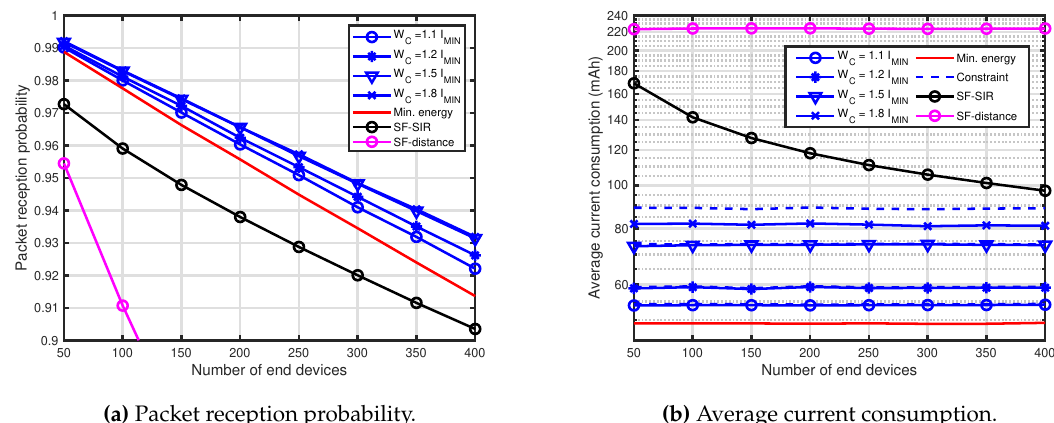
= 1.1 I mAh, 1.2 I C MIN